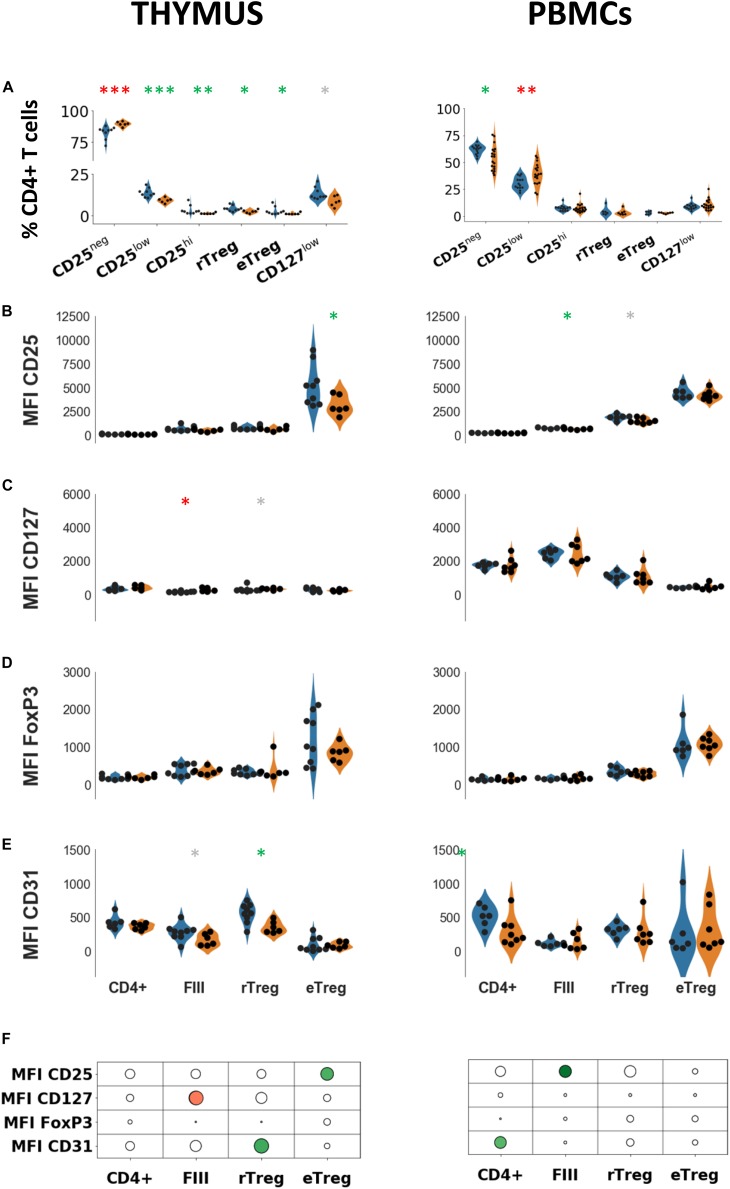
Phenotypic characterization of thymic and peripheral regulatory cells. (A) Percentages of indicated cell populations among total CD4 + T cells in healthy individuals (blue) or in myasthenic patients (orange) in the thymus (left panel) or in PBMCs (right panel). Mean fluorescent intensities of CD25 (B), FoxP3 (C), CD127 (D), CD31 (E) in healthy individuals (blue) or in myasthenic patients (orange) in the 3 subsets defined by the combination of CD45RA and CD25 in thymus (left panel) or in PBMCs (right panel). Statistical test: two-tailed Mann-Whitney (∗p ≤ 0.05; ∗∗p ≤ 0.01; and ∗∗∗p ≤ 0.005, gray star corresponds to p < 0.1). (F) Statistical summary of the data shown in (B–E). Colorized bubbles correspond to significant differences. Size is proportional to the statistical significance and color represents fold change between mean values of control individuals and MG patients (green, lower value in MG; red, higher value in MG).